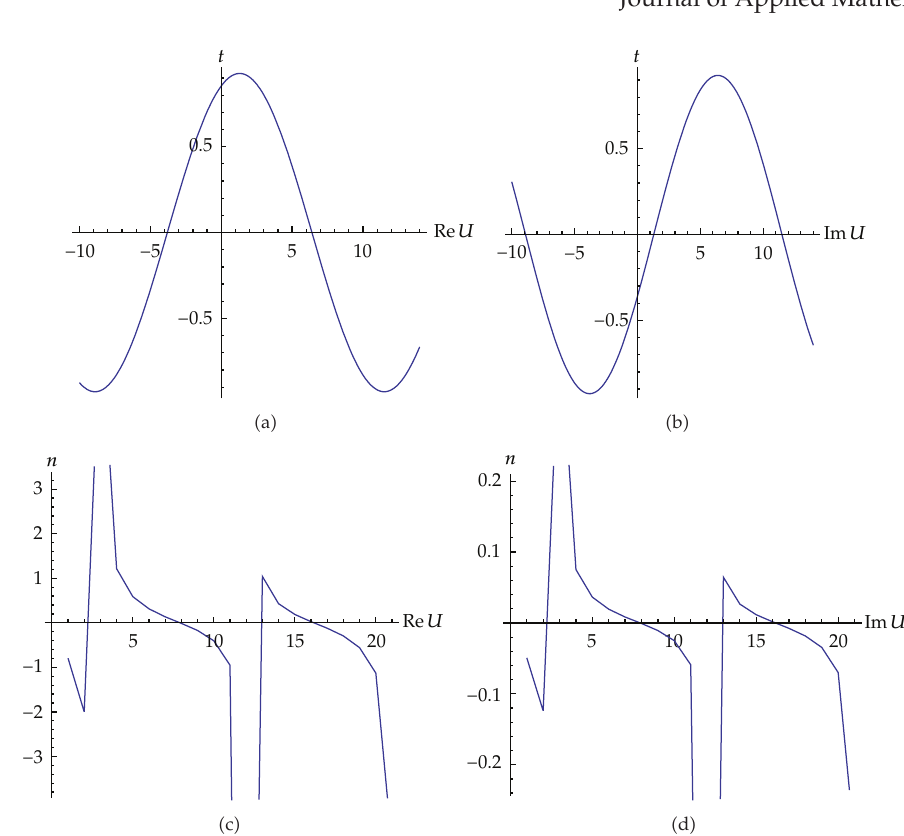
Figure 2: (cid:5) a (cid:6) and (cid:5) b (cid:6) represent the Jacobi elliptic solution (cid:5) 3.30 (cid:6) when m (cid:9) 0 . 5, β (cid:9) 1 . 5, α (cid:9) 0 . 2, ρ (cid:9) 0 . 4, n (cid:9) 2. (cid:5) c (cid:6) and (cid:5) d (cid:6) represent the Jacobi elliptic solution (cid:5) 3.30 (cid:6) when m (cid:9) 0 . 5, β (cid:9) 1 . 5, α (cid:9) 0 . 2, ρ (cid:9) 0 . 4, t (cid:9) 1 .